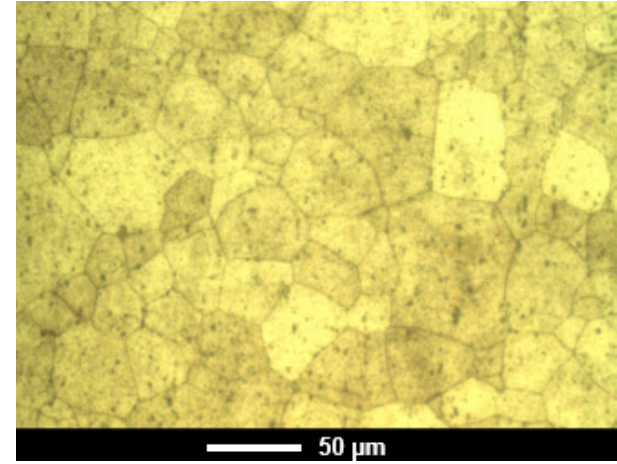
Figure 4. General OM image of the commercial Al after etching.